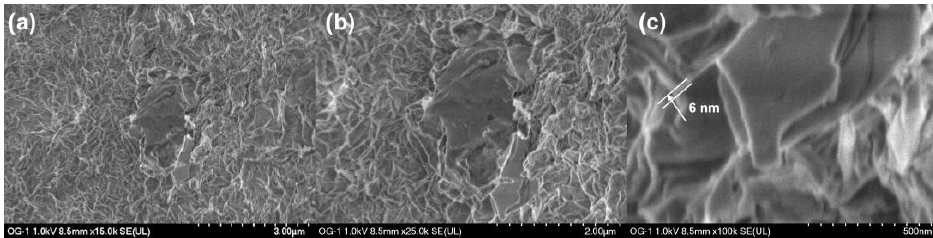
Figure 7. SEM image of GO60 sheets ( a ) ×15,000, ( b ) ×25,000 and ( c ) ×100,000. Network thickness of graphene oxide layers of ≈ 6 nm on average.